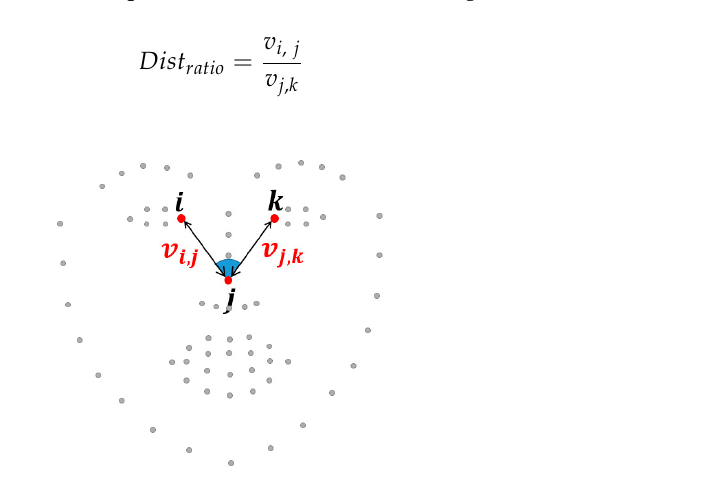
Figure 2. Geometric features using the spatial relations among three landmarks { i , j , k } such as the distance ratio and angles relations.